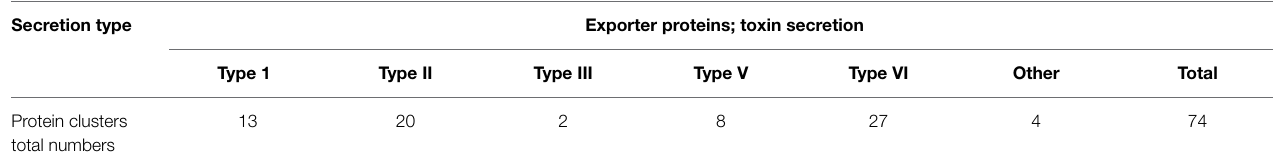
TABLE 4 | Exporter proteins related to common secretion types seen in pathogenic bacteria. Numbers refer to the total number of protein clusters in each secretion type. Secretion